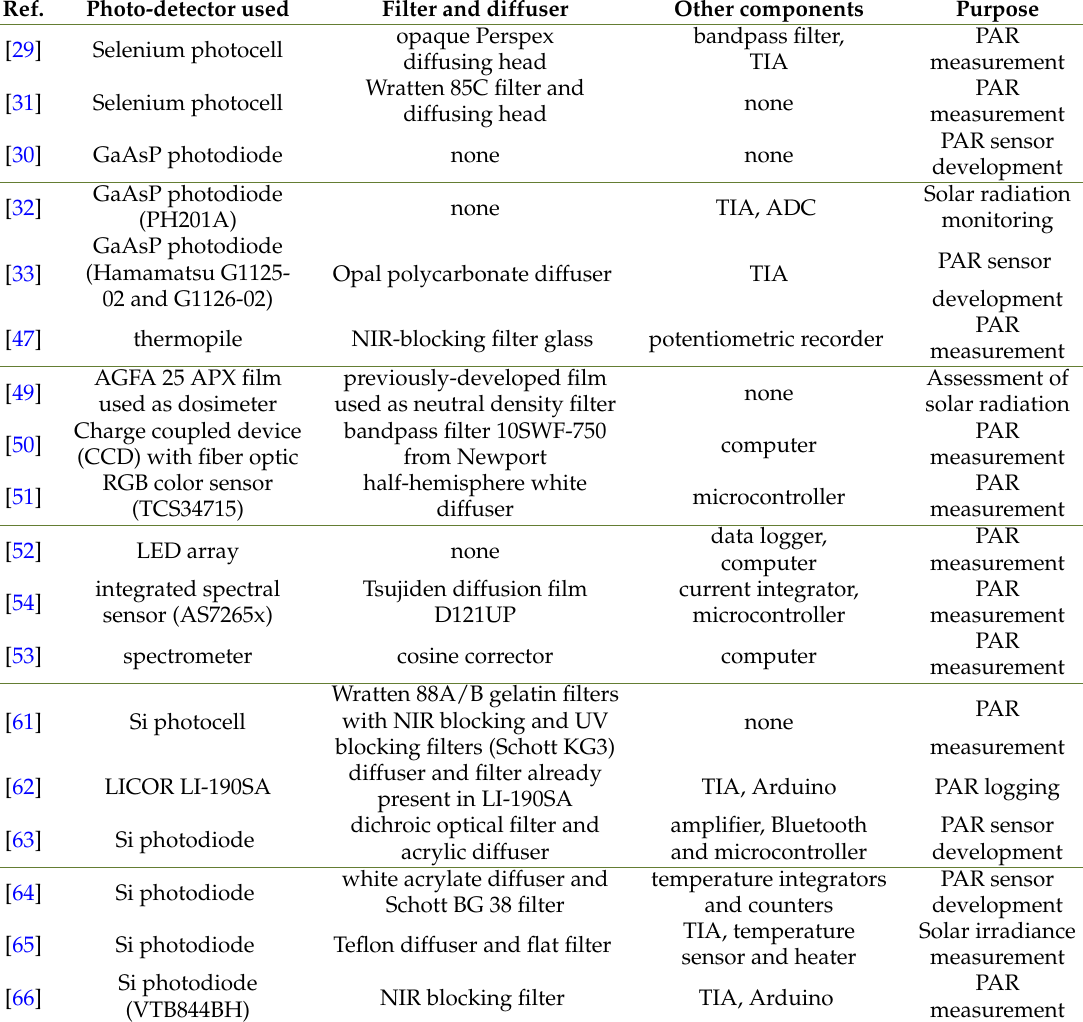
Table 1. Summary of custom sensors used for PAR measurement